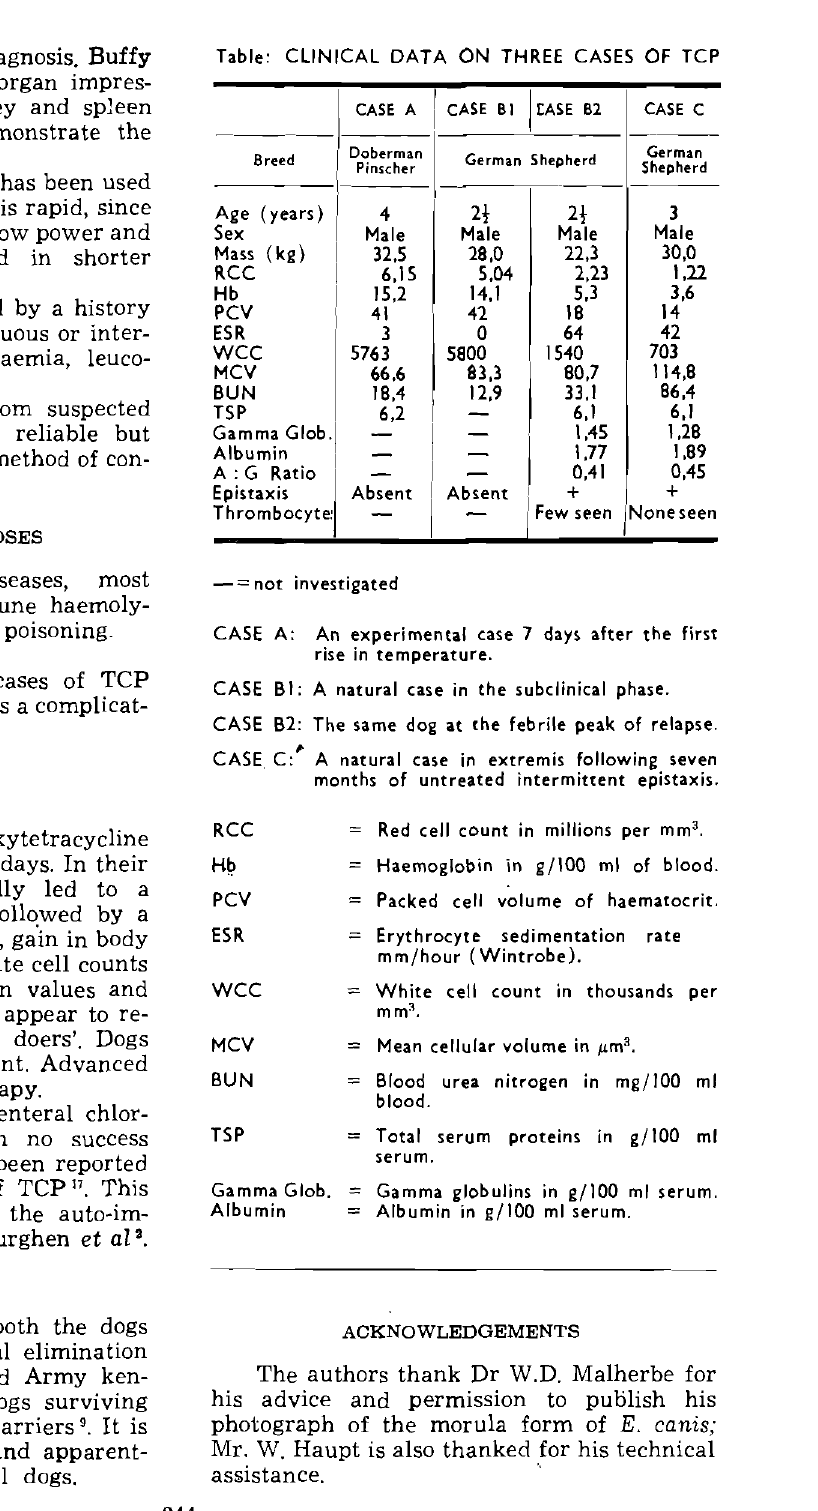
Table: CLINICAL DATA ON THREE CASES OF